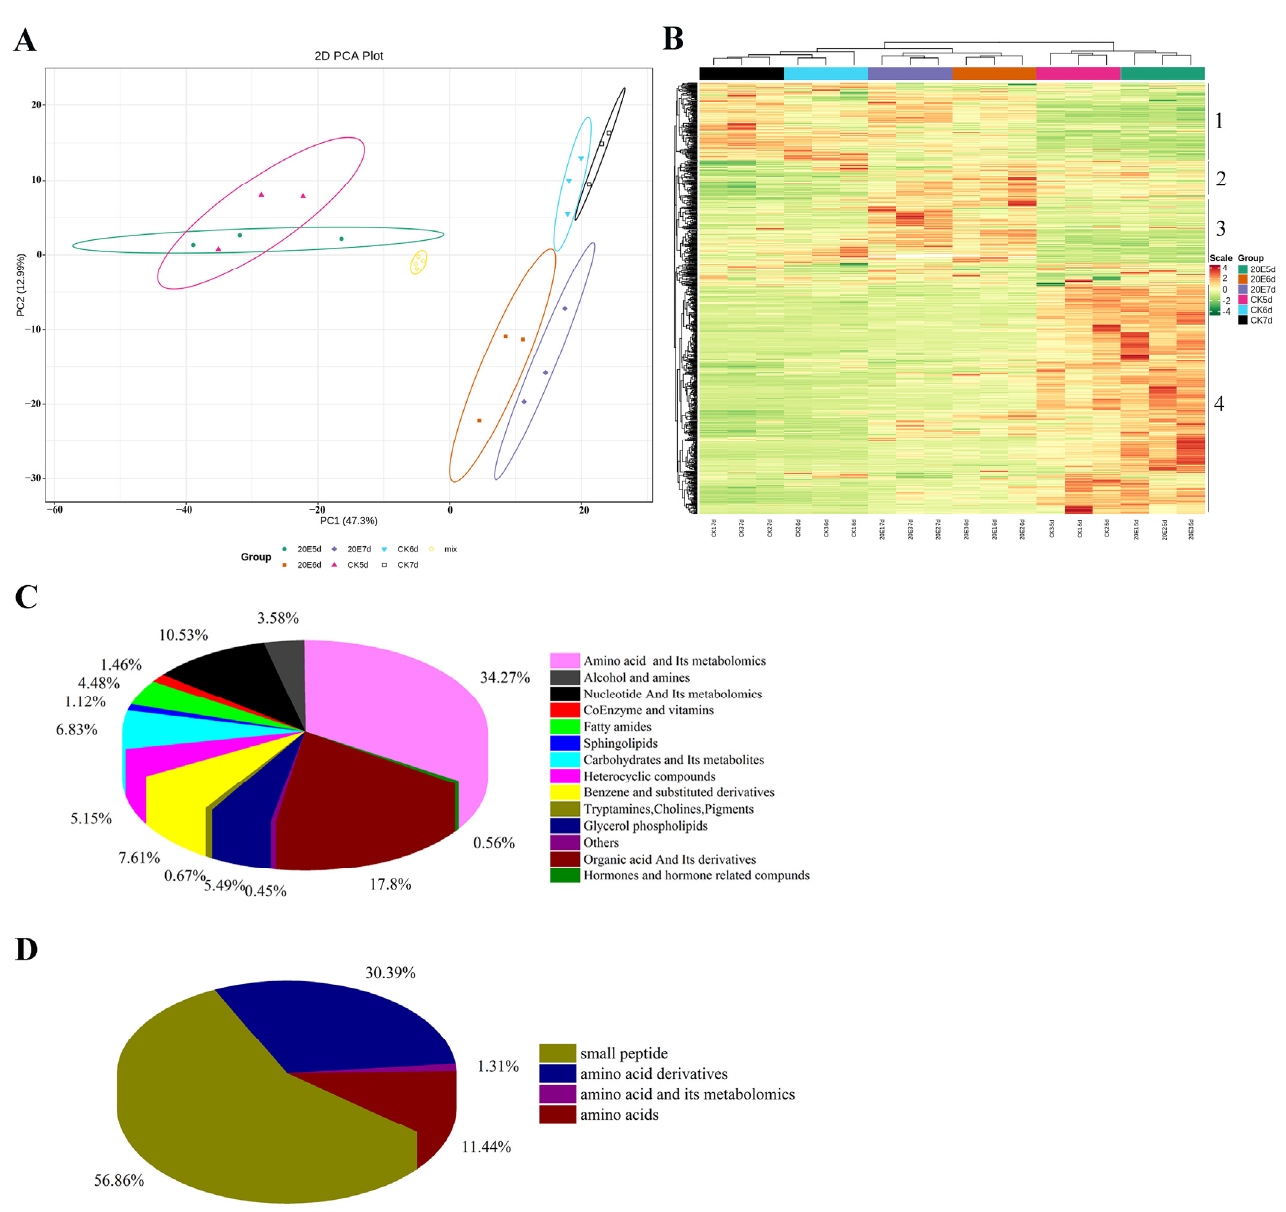
Figure 2. ( A ) Principal component analysis (PCA) of the different samples. Each point represents one metabolite. There were three biological repeats for each treatment. ( B ) Hierarchical clustering analysis (HCA) of widely targeted metabolomics of the different samples. Red indicates high abundance; green indicates low abundance. Metabolites were divided into four main clusters. The classification of all the detected metabolites ( C ) and amino acids ( D ) of larvae hemolymph samples. A Venn diagram was created using all these data based on the differentially